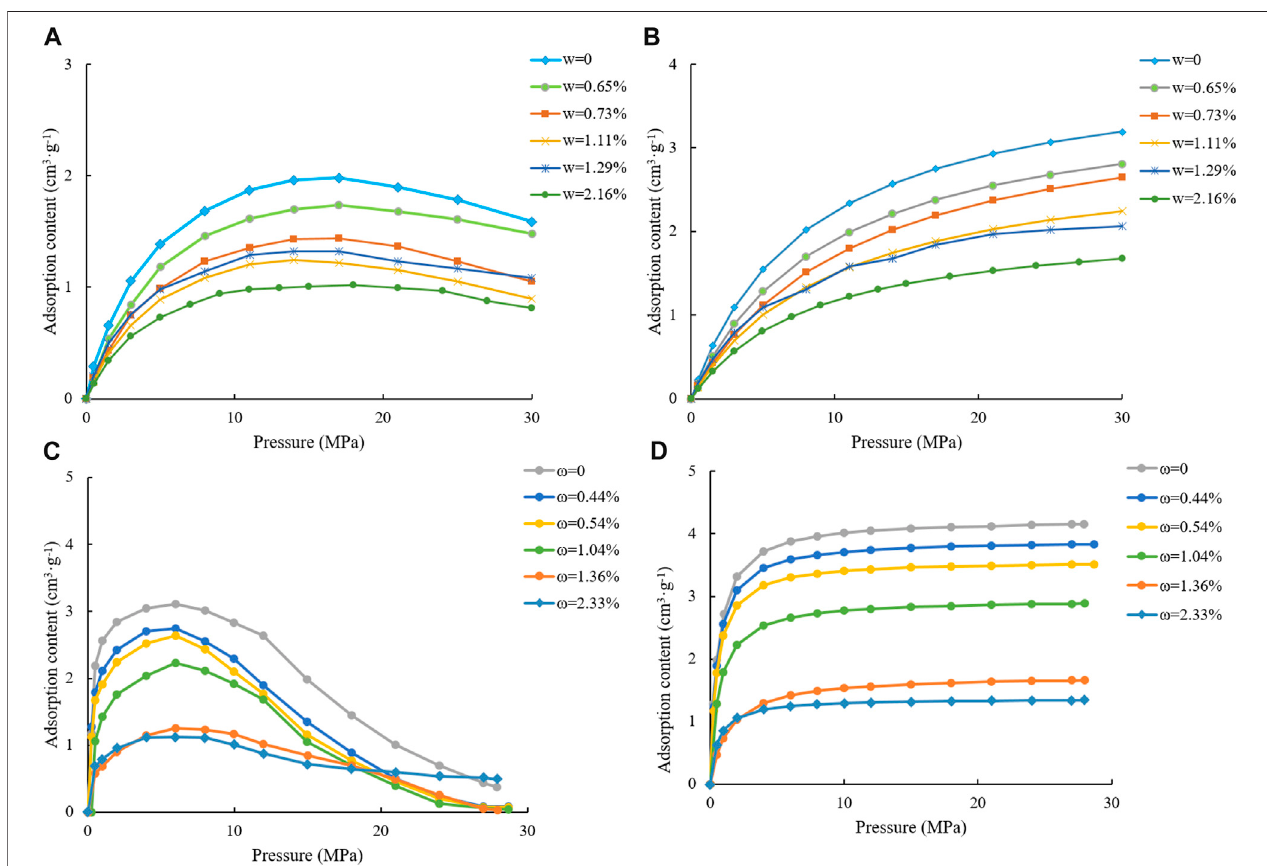
FIGURE 10 | Test results of excess adsorption and Langmuir three-parameter fi tted results of samples #2 and #6 at different moisture contents. [ (A) Measured adsorptioncapacityunder different watercontentsofsample#2; (B) .Adsorptioncapacity under differentwatercontents usingthe ternary Langmuir equation ofsample #2; (C) Measured adsorption capacity under different water contents of sample #6; (D) Adsorption capacity under different water contents using the ternary Langmuir equation for sample #6.].